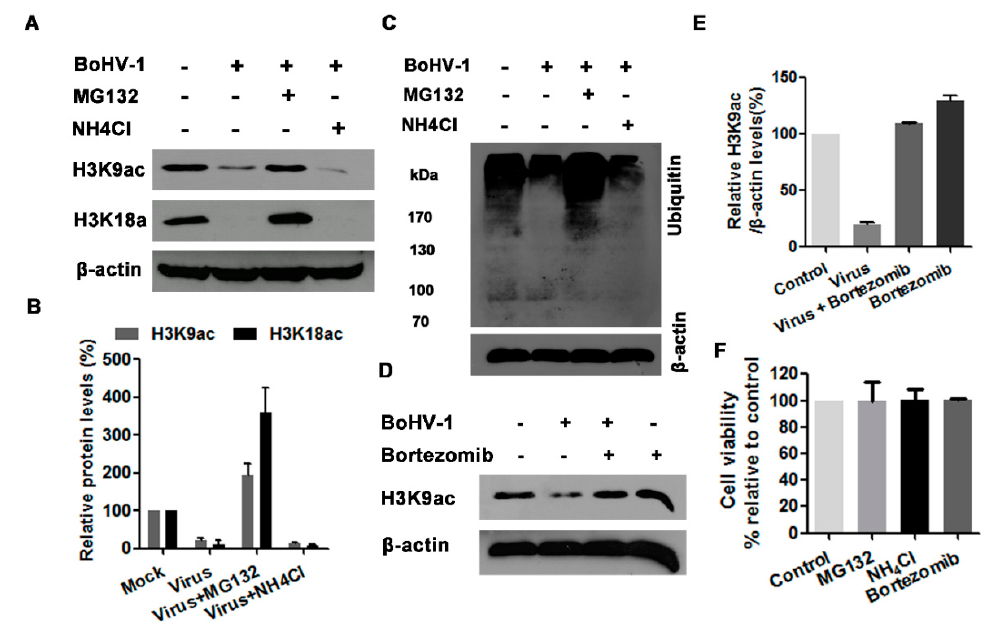
Figure 5. The effects of ubiquitin-proteasome pathway on histone H3 acetylation. ( A , C ) MDBK cells in 60 mm dishes were mock infected or infected with BoHV-1 (MOI = 1) and treated with either MG132 (1 µ M) or NH4Cl (10 mM), or mock treated with DMSO vehicle for 24 h. The cell lysates were prepared for Western blots to detect the expression of H3K9ac and H3K18ac ( A ), and the ubiquitined protein ( C ). Data shown are representative of three independent experiments. ( D ) MDBK cells in 60 mm dishes were infected with BoHV-1 (MOI = 1) and treated with bortezomib (2 nM), or mock treated with DMSO control for 24 h. The cell lysates were prepared for Western blots to detect the expression of H3K9ac. Data shown are representative of three independent experiments. ( B , E ) The band intensity was analyzed with software image J. Each analysis was compared with that of uninfected control which was arbitrarily set as 100%. The error bars denote the variability between the three independent experiments. ( F ) The cytotoxicity of MG132 (1 µ M), ammonium chloride (NH4Cl) (10 mM) and bortezomib (2 nM) in MDBK cells for 24 h was analyzed by Trypan-blue exclusion test. Data represent the means of three independent experiments. +: indicated compound or virus was present, − : indicated compound or virus was not